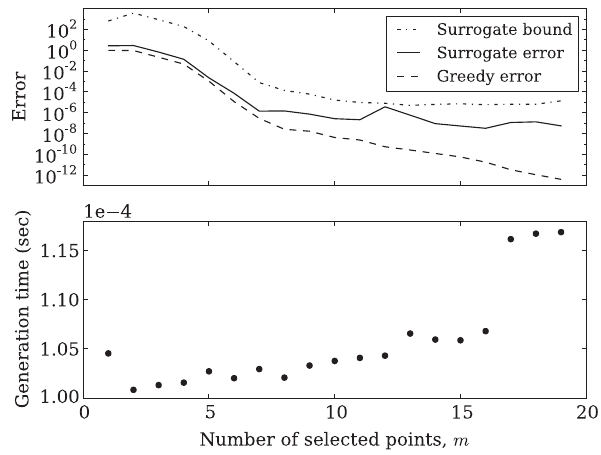
FIG. 11. Top panel: The greedy error in Eq. (9) computed for 1,000 randomly selected waveforms (dashed line) and the error (31) of the resulting surrogate model (solid line) as a function of the number of basis waveforms m . Because of the fitting errors (see Sec. III C), the surrogate error is roughly constant after m ¼ 7 , implying little practical gain in using more than seven basis waveforms. The dash-dotted line shows an averaged error bound provided by the right side of Eq. (33). Bottom panel: Average time to evaluate a surrogate waveform (at a sampling rate of 2,048 Hz) as a function of m . As expected, there is only mild growth with m .